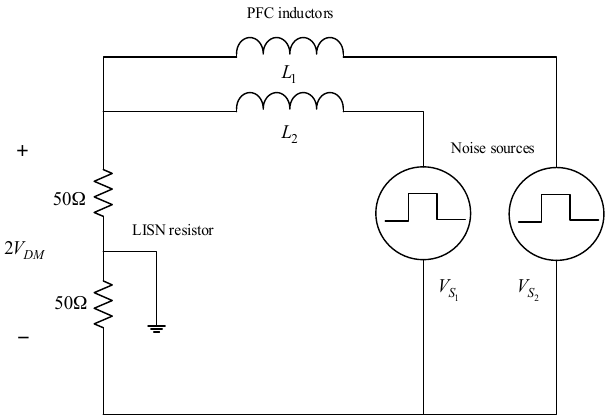
Figure 3. DM noise model for the interleaved PFC converter.